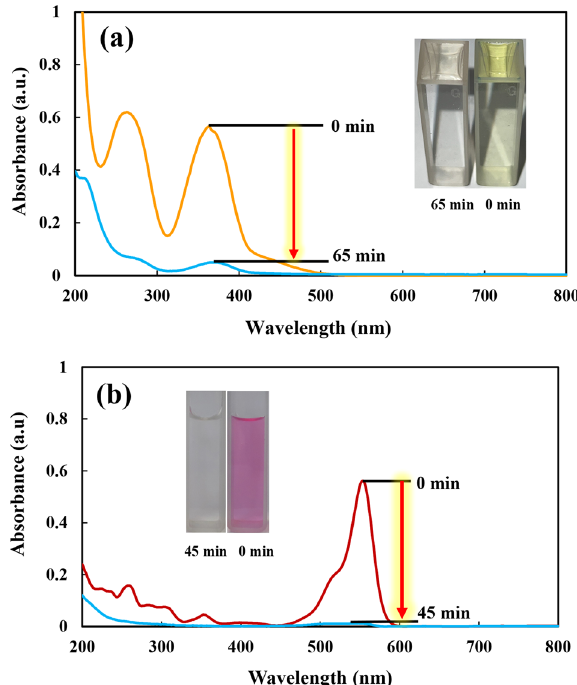
Fig. 8 UV-Vis spectra and photographic images (before and after photocatalysis). a Cr 6 + solution. b RhB solution.